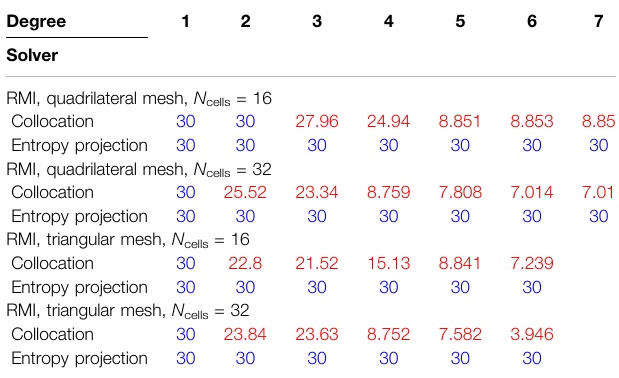
TABLE 3 | End time for simulations of the Rayleigh-Taylor instability on quadrilateral and triangular meshes. On quadrilateral meshes, “ collocation ” refers to a nodal DGSEM discretization, while “ entropy projection ” refers to a method based on Gauss nodes. On triangular meshes, “ collocation ” refers to nodal SBP discretization, while “ entropy projection ” refers to a modal entropy stable DG method.